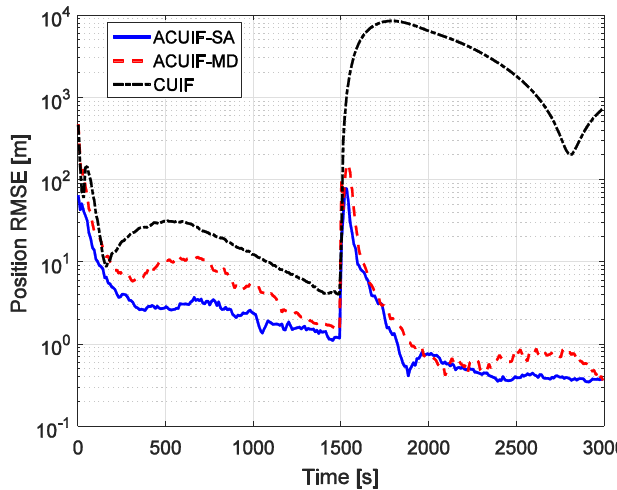
Figure 5. The position RMSE for different methods over time in case 2. Figure 6. The position RMSE for di ff erent methods over time in case 2.